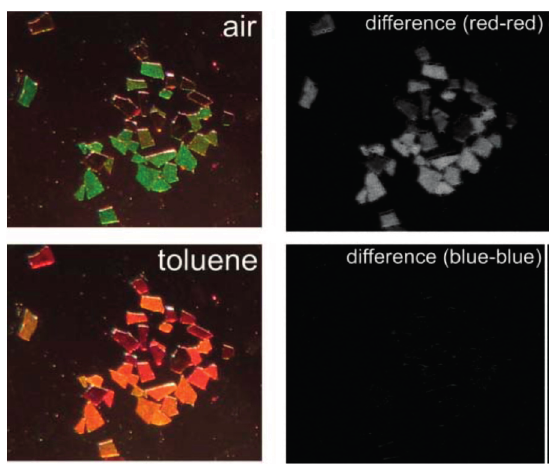
Figure 8. Sensing volatile organic compounds using ‘‘smart dust’’ photonic crystals. An array of microscopic porous Si photonic crystals exposed to toluene vapor is shown in these images. The top left image is the collection held in air. Bottom left is the sample after introduction of toluene vapor. The images on the right are difference maps, showing the difference between the red ( top right ) and blue ( bottom right ) channels. The size of these particles is of the order of 300 nm, and their surfaces are modified with dodecyl functionalities. Adapted with permission from Reference [79]. Copyright 2005 the Royal Society of